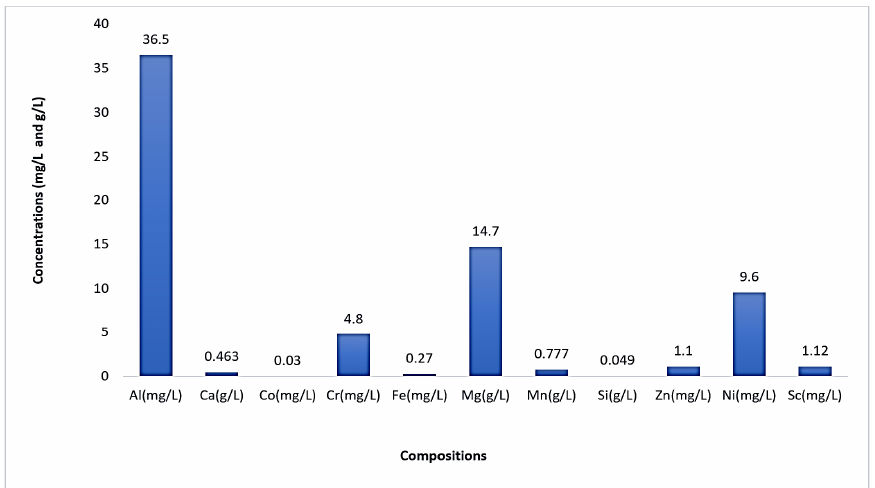
Figure 13. The composition of laterite ore H 2 SO 4 -leached solution, after neutralization and sulphide precipitation, adapted from [19].